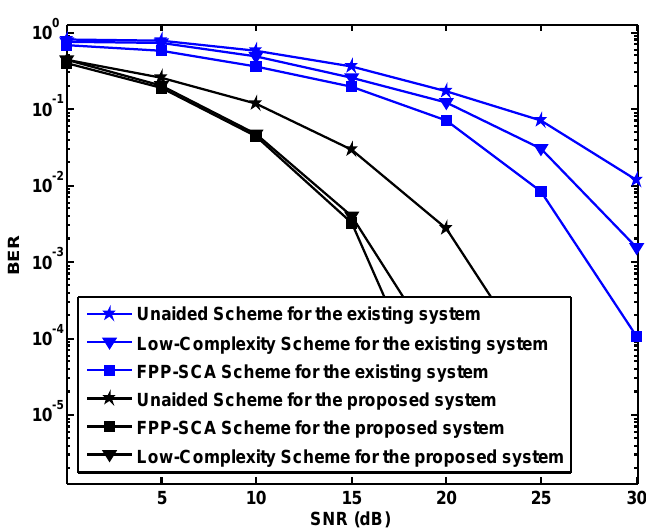
Figure 6. The comparison between the proposed network and existing BWSN N = M =